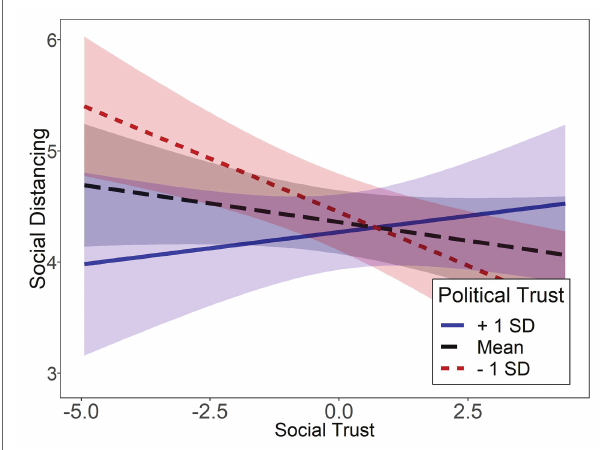
FIGURE 1 | Simple slopes of social trust predicting social distancing at different levels of political trust in Study 1 are displayed. Ribbons represent 95% confidence